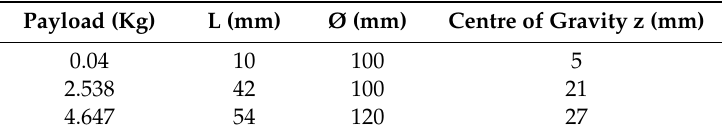
Figure 1. Payload side view. Table 2. Payload parameters.